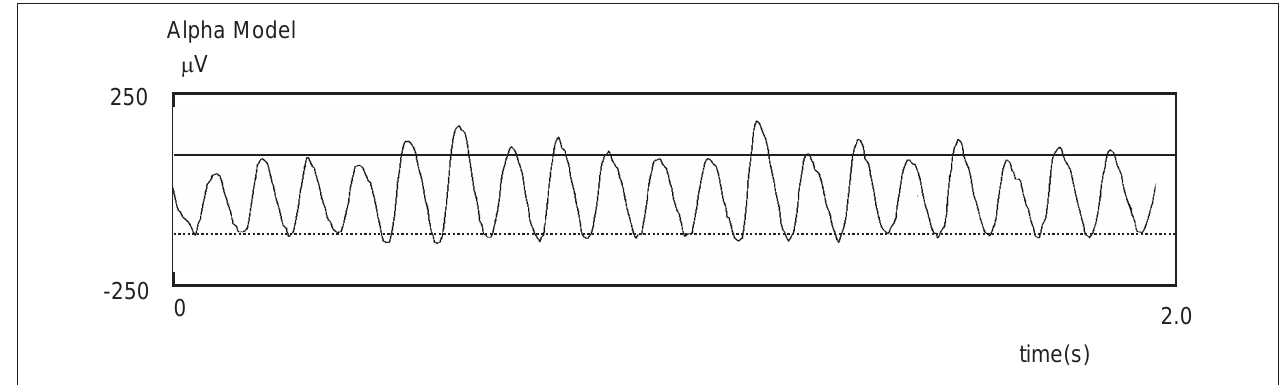
Figure 10 | An alpha rhythm time-series displaying non-sinusoidal properties. Prior to the discovery of its link to the formation of evoked responses, amplitude asymmetry had been observed in models designed to produce alpha activity. Here is an example adapted from Stam et al. (1999a).